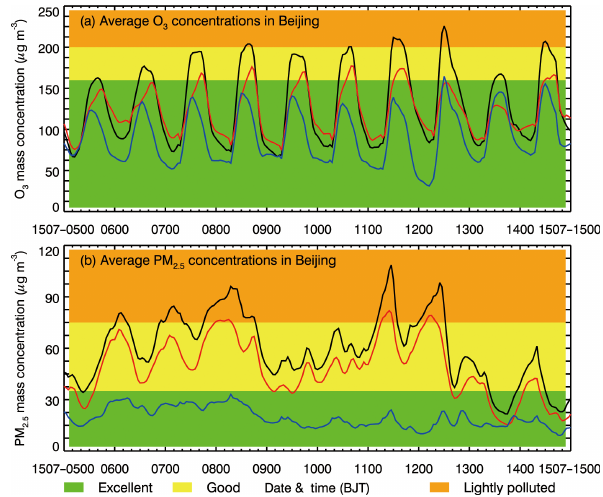
Figure 10. Temporal variations of the average near-surface O 3 and PM 2 . 5 concentrations from f BS with all the emissions (black line), f B with Beijing emissions alone (blue line), and f S with non- Beijing emissions alone (red line) in Beijing from 5 to 14 July